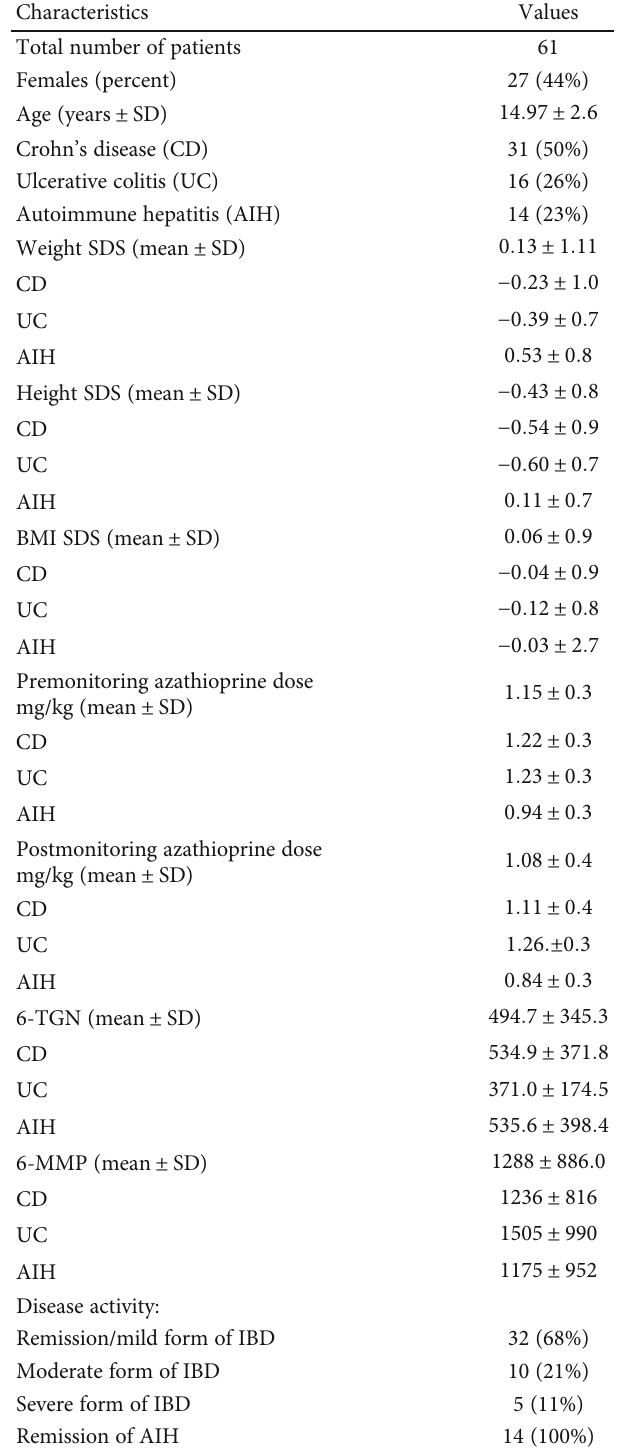
Table 1: Background information about the group receiving